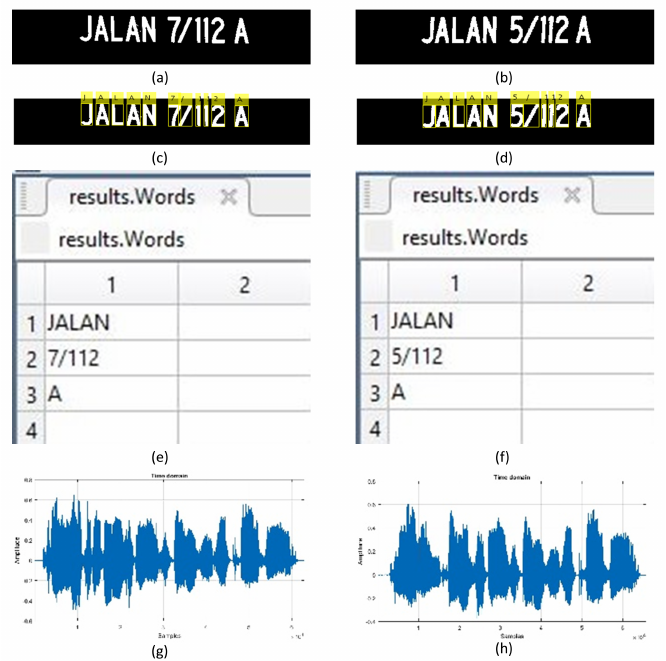
Figure 8. Presentation of recognised street signs: ( a , b ) are street signs, ( c , d ) are annotated street signs with recognised text, ( e , f ) are extracted text words, and ( g , h ) are the voice